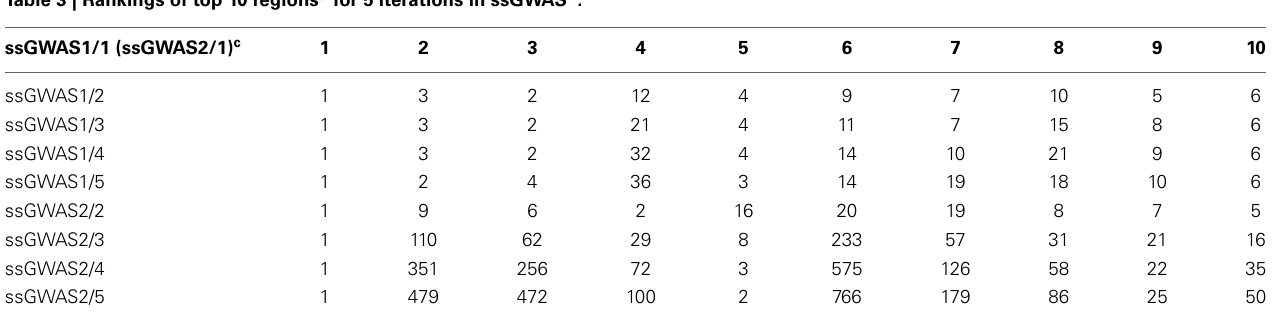
Table 3 | Rankings of top 10 regions a for 5 iterations in ssGWAS b